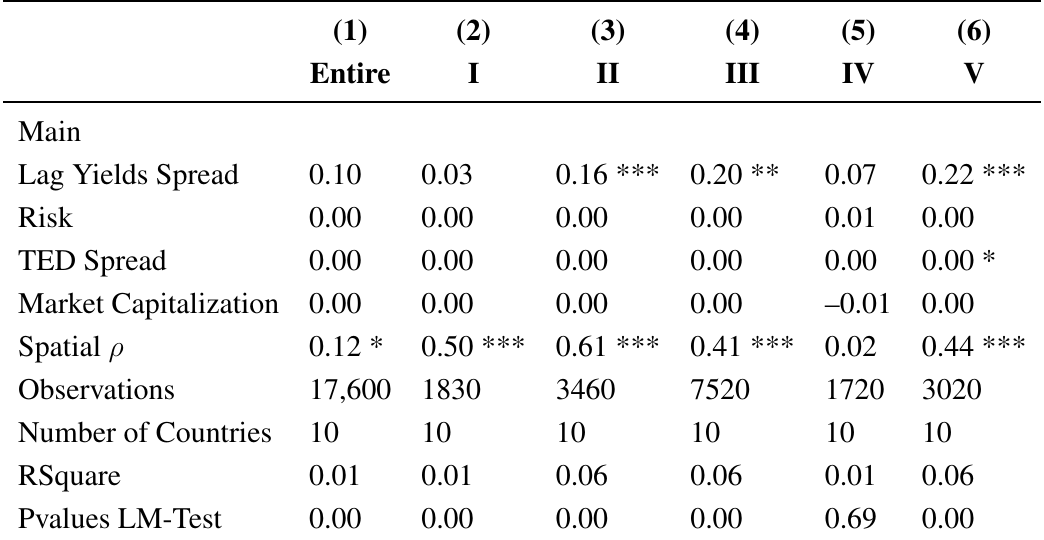
Table 5. Empirical results for the entire sample of EMU